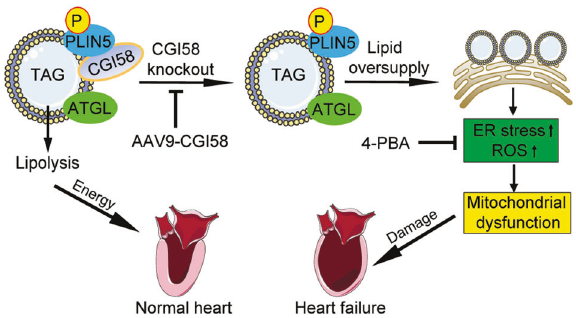
Fig. 8 A working model for CGI-58 to regulate cardiac function. Under normal condition, CGI-58 binds and activates ATGL to promote lipolysis, which then provides energy to the heart. Conversely, CGI-58 knockout inhibits lipolysis and increases